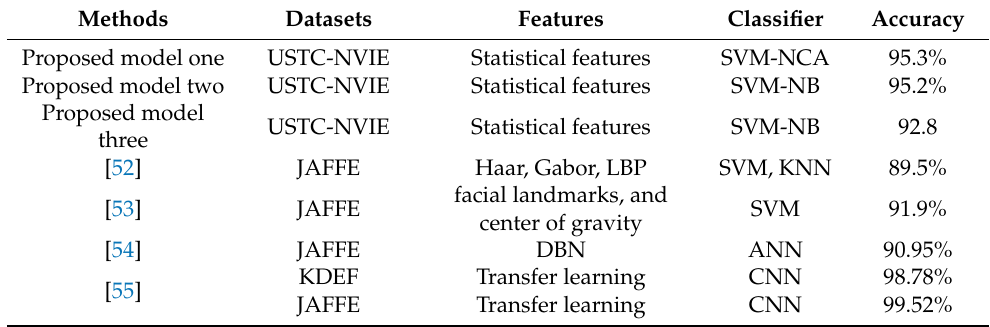
Table 8. Comparative results with other studies in the literature based on visual facial images